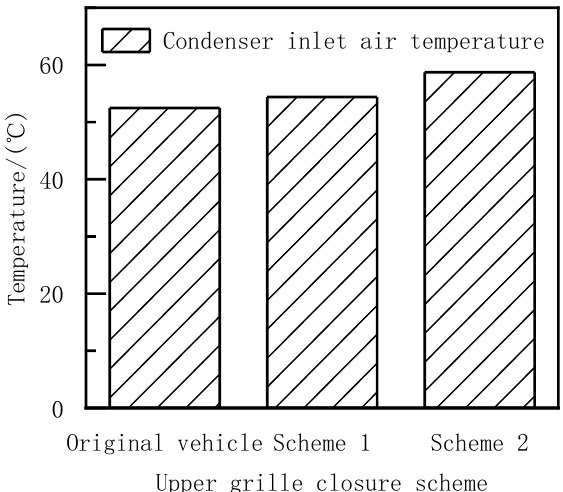
Figure 16. Velocity fields of z = 0.44 m section under different upper grille closure schemes: ( a ) original vehicle; ( b ) scheme 1; ( c ) scheme 2.